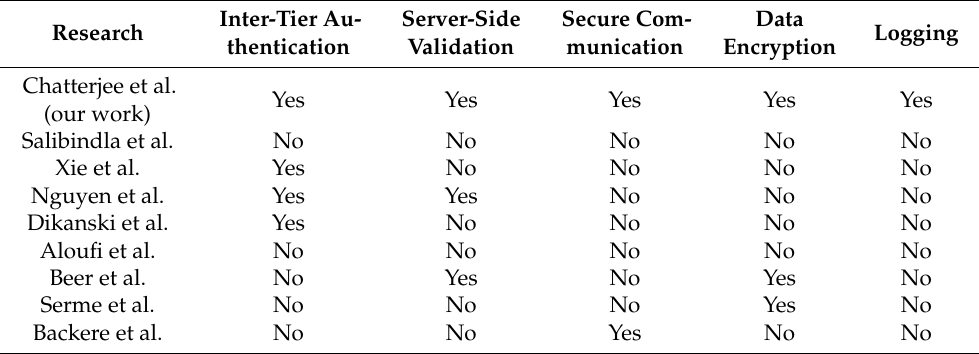
Table 17. Comparative analysis of our security solution with existing MSSA with respect to the key attributes of a secure web application architecture.